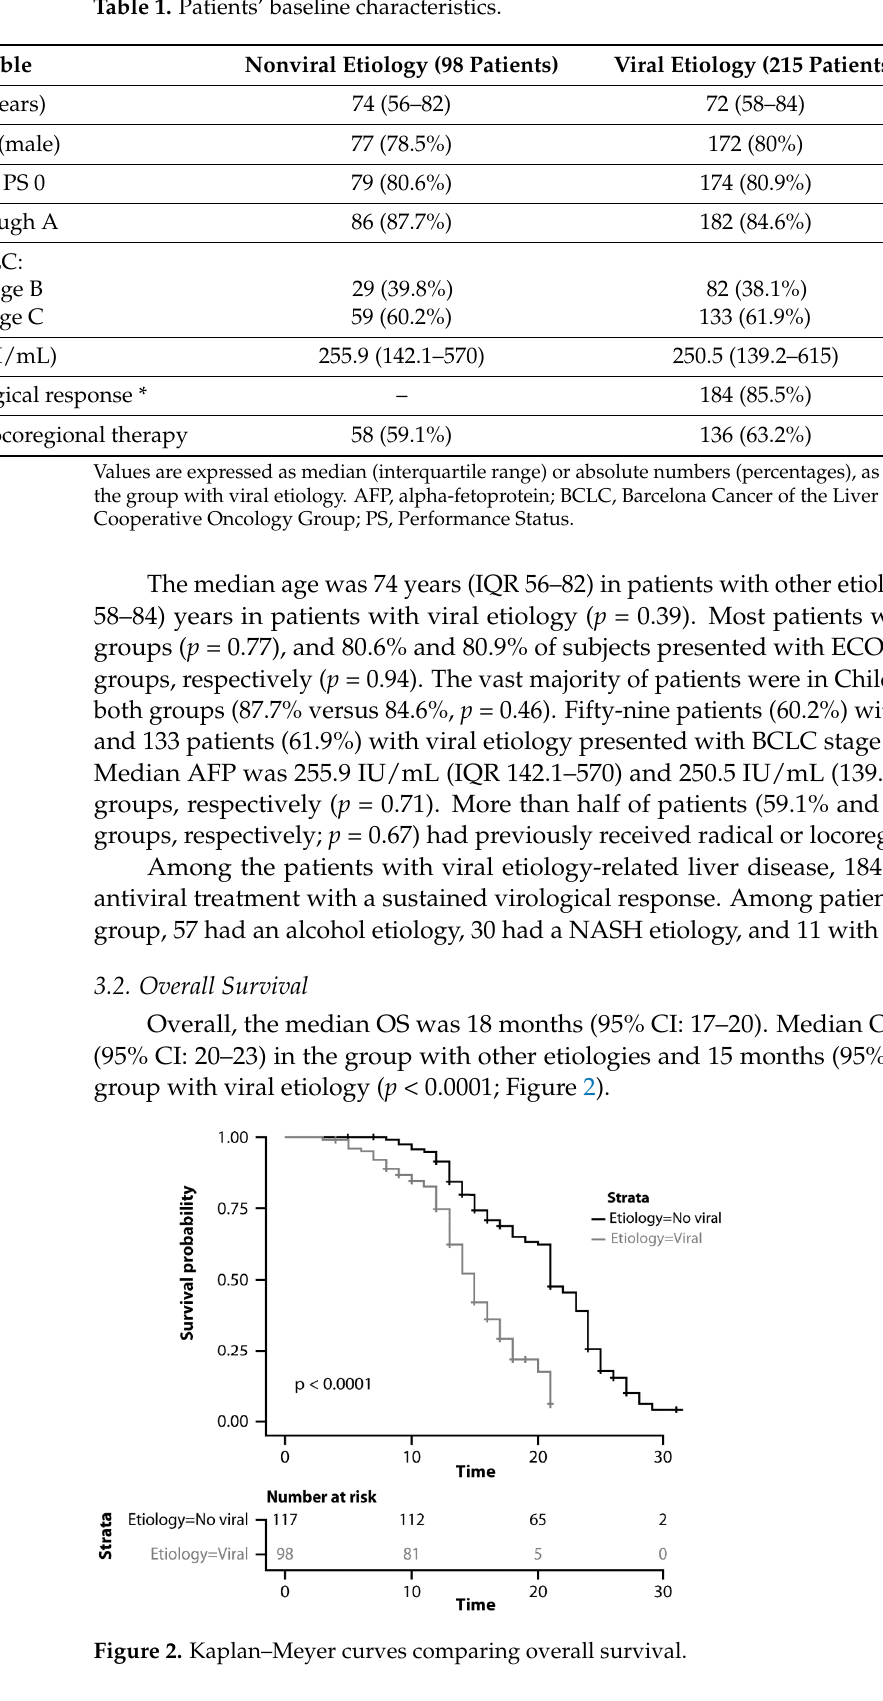
Table 1. Patients’ baseline characteristics.